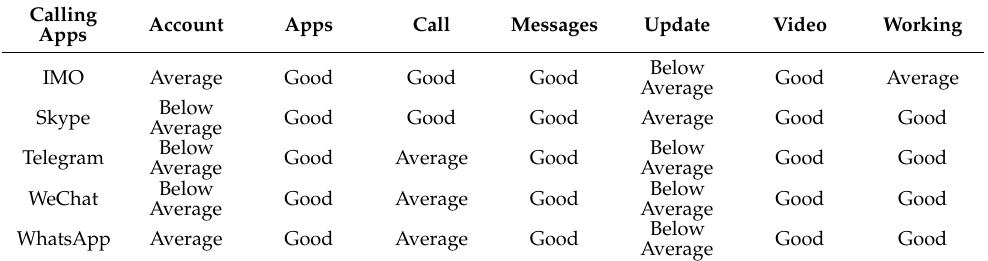
Table 18. Aspect-based analysis of calling apps and their categorization.